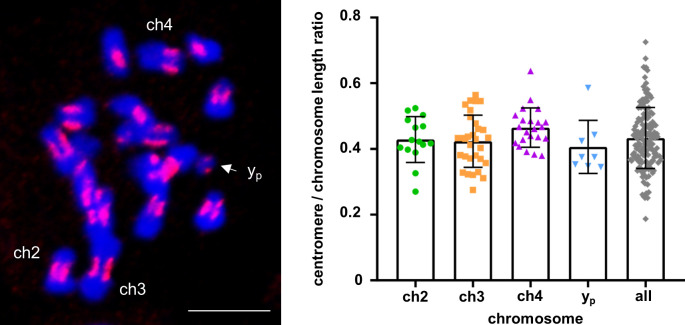
Tribolium castaneum relative centromere length estimation.Centromere length relative to chromosome length was calculated from 240 measured chromosomes. The left panel shows a representative chromosome spread with DAPI-stained chromosomes (shown in blue) with red-stained cCENH3 regions. Centromere length was defined as the distance between the two outermost cCENH3-containing domains at each chromosome. The scatter plot displays values for all measured chromosomes, and for the individual chromosomes ch2, ch3, ch4 and yp that can be distinguished in the chromosome complement (marked in the left panel, scale bar = 5 μm). Error bars represent standard deviations of the underlying measurement data supplied in the S3 Appendix.